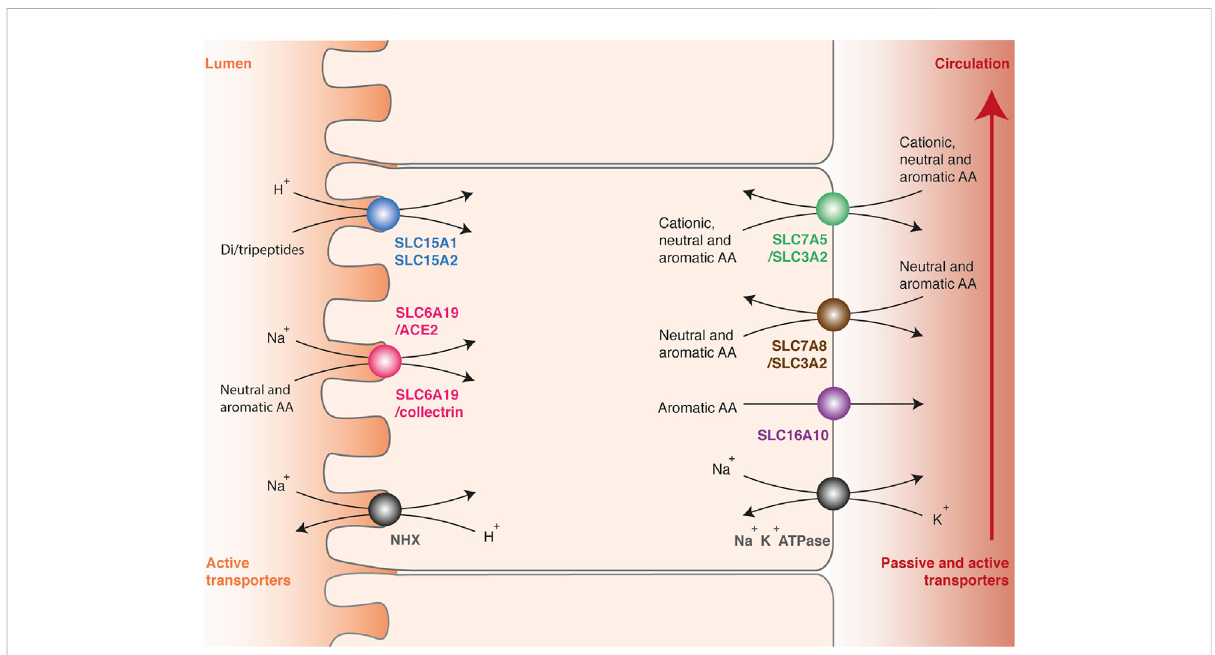
FIGURE 2 Intestinal absorption and renal reabsorption of tryptophan. Transport of tryptophan involves two successive steps across polarized cells. First, tryptophan is transported against the concentration gradient from the lumen to the cytosol of epithelial cells by apical transporters using the electrochemicalpotential gradient of sodium ion or proton (left side). Tryptophan iscaptured inpeptidicor freeform, bydi-/tripeptides transporters SLC15A1 and SLC15A2 (blue) or by neutral amino acid transporters SLC6A19/ACE2 and SLC6A19/collectrin (pink), respectively. Secondly, tryptophan is released from the cytosol to the blood through basolateral transporters (right side), namely the multiple amino acid exchangers SLC7A5/SLC3A2 (green) and SLC7A8/SLC3A2 (brown), or the passive aromatic transporter SLC16A10 (purple). The electrochemical gradient of protons (pH < 6.5) is maintained by the apical Na + /H + exchanger NHX (grey, left side). The electrochemical gradient of sodium is maintained by the basolateral Na + /K + ATPase (grey, right